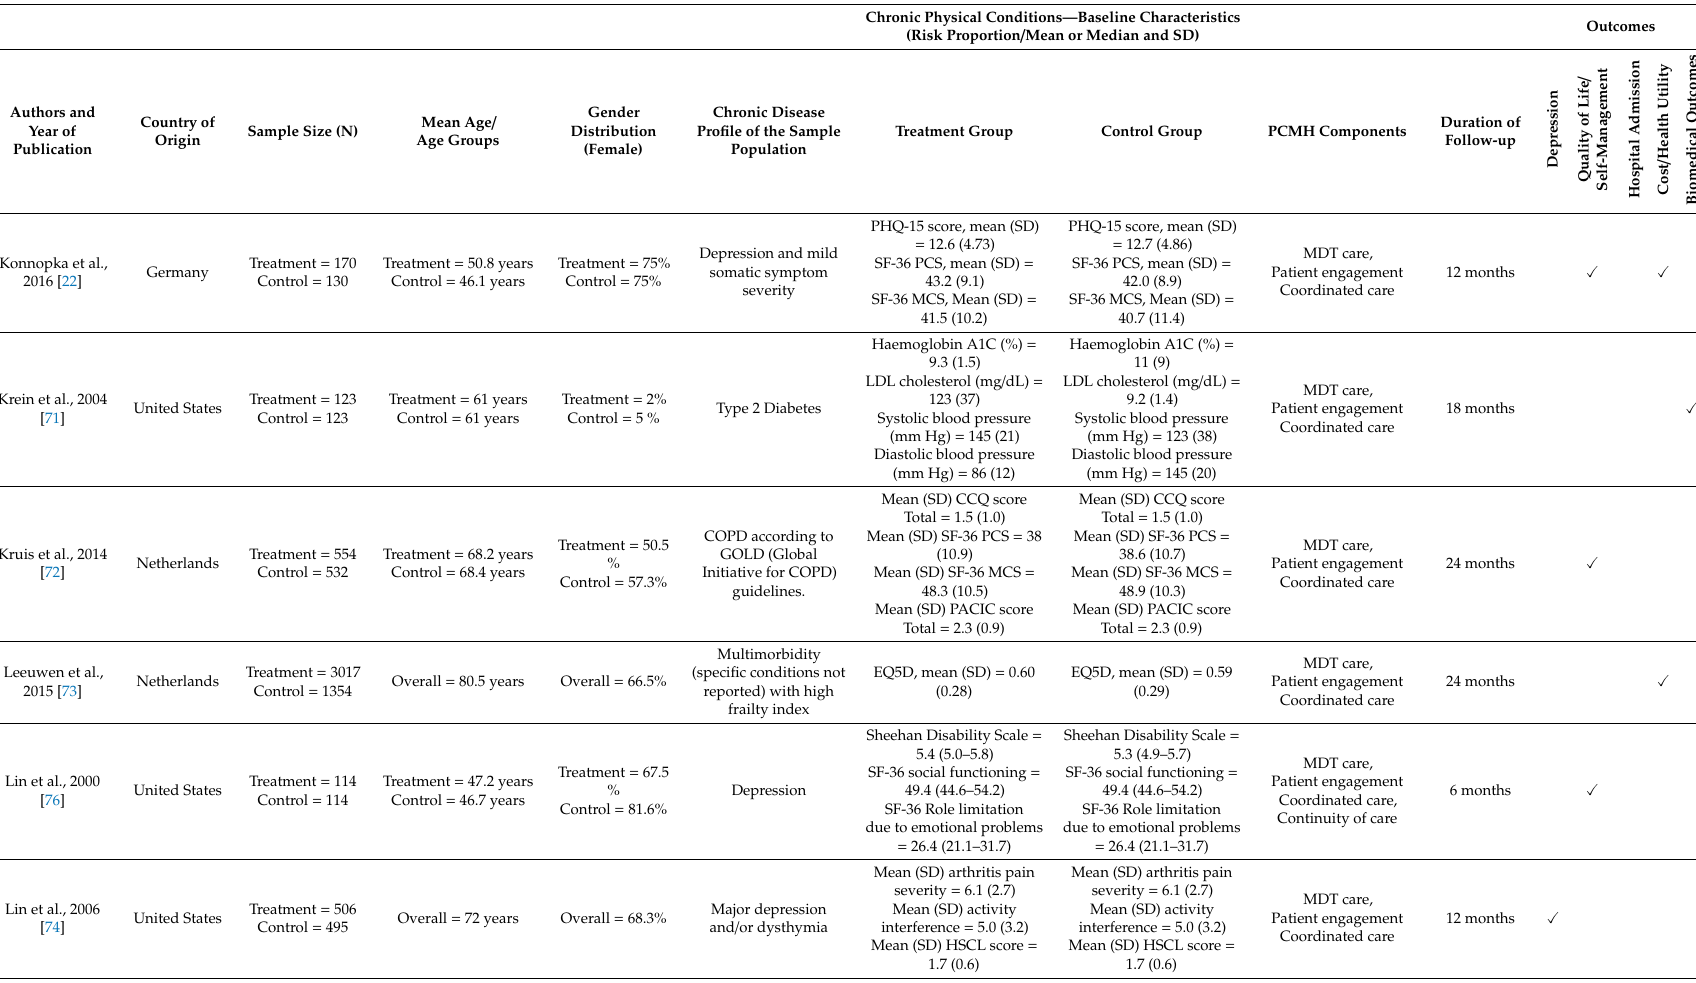
Table A3. Cont. Chronic Physical Conditions—Baseline Characteristics (Risk Proportion / Mean or Median and SD)